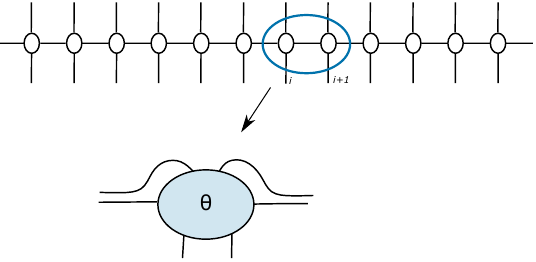
Figure 18. The state (cid:2). We combine the bond and physical degrees of freedom into a pair of physical indices represented by the horizontal legs. The ancilla degrees of freedom (the bottom legs) are acted upon by our two-site disentangler.